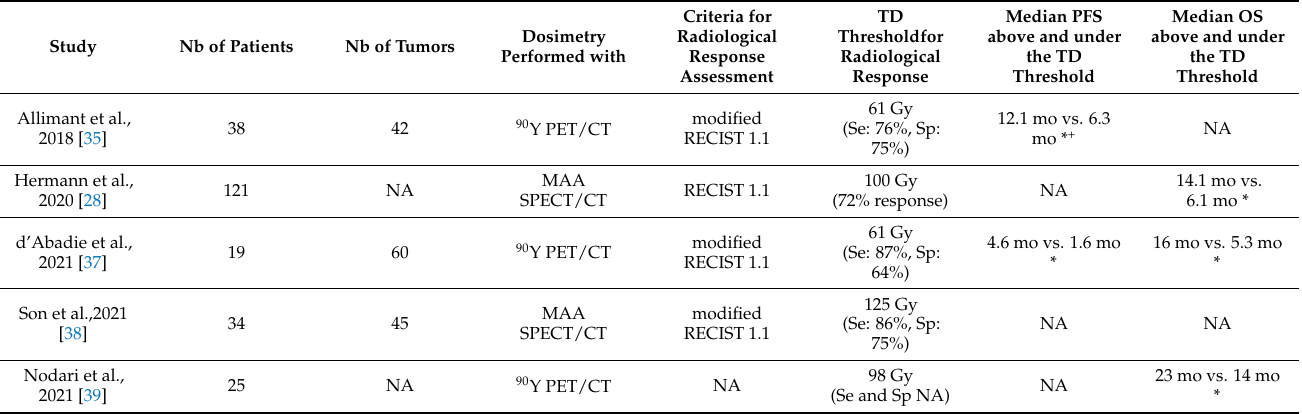
Table 4. Main studies reporting threshold absorbed doses correlated with clinical outcome in hepato- cellular carcinoma using resin